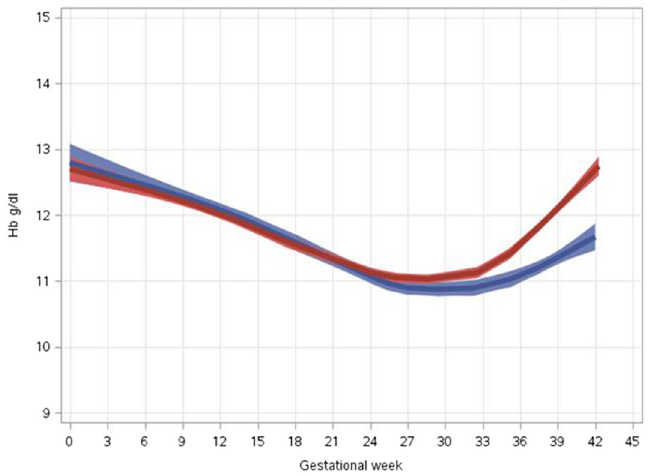
Figure 1. Hemoglobin throughout pregnancy. LOESS curve of hemoglobin levels among pregnant women with frequent (red line) and infrequent (blue line) use of iron supplements.